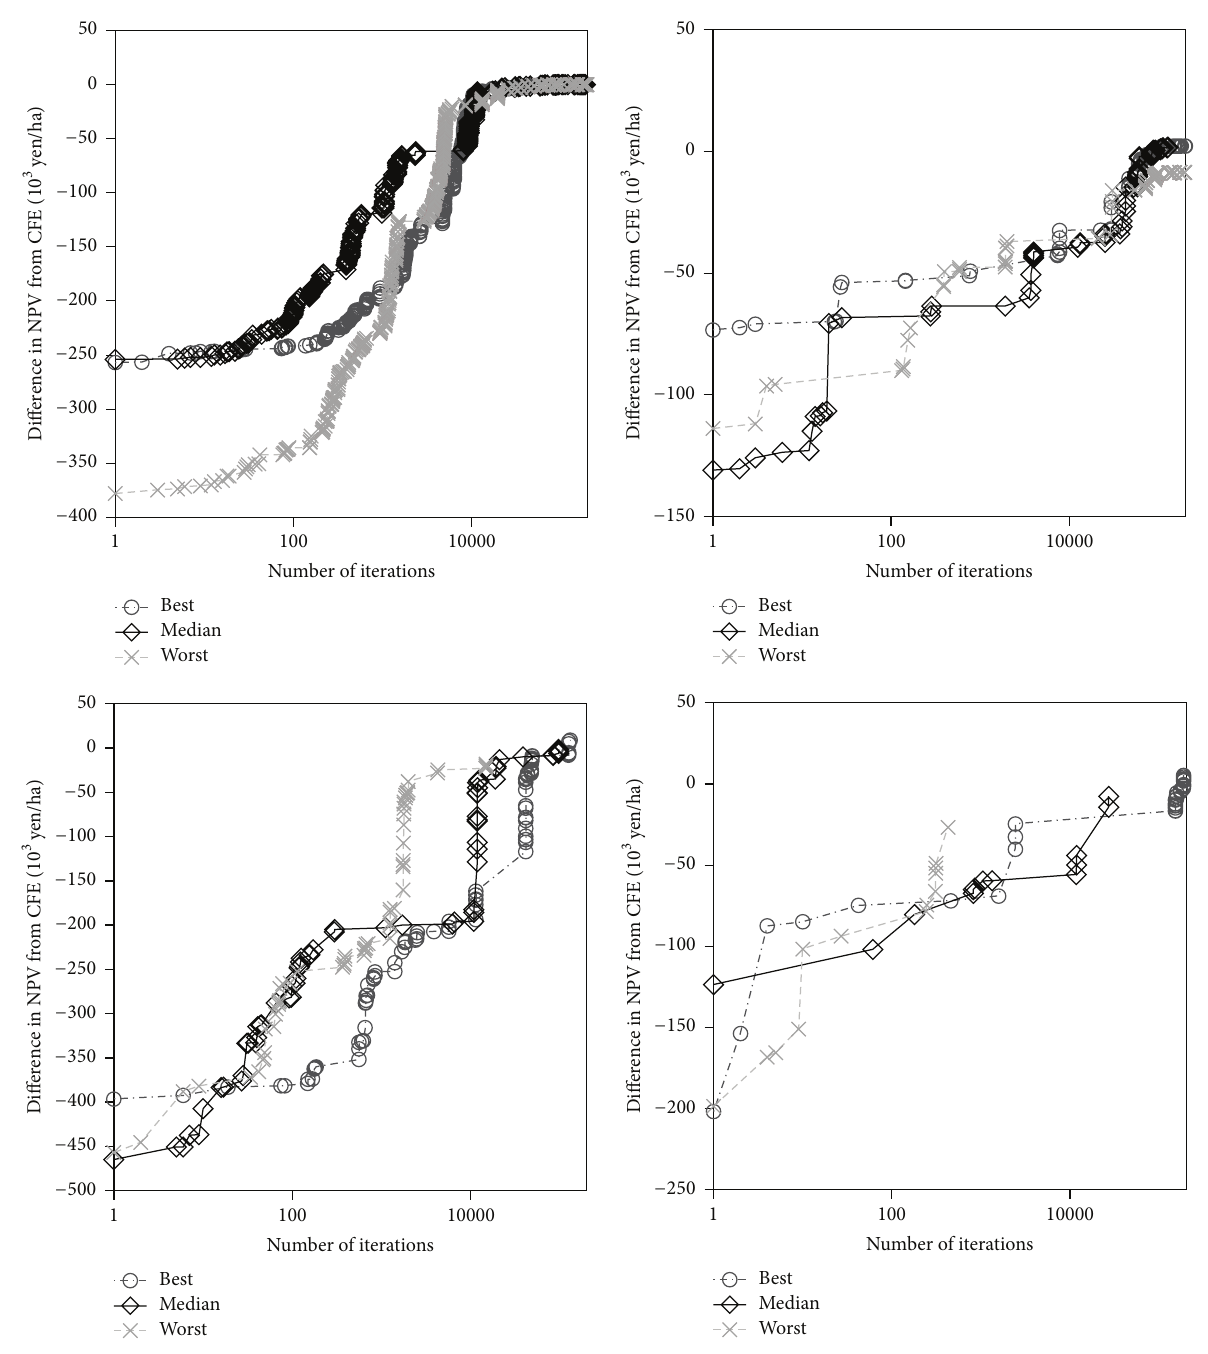
Figure 5: Updating processes of NPV of SA (upper: S; lower: L; left: H; right: F).